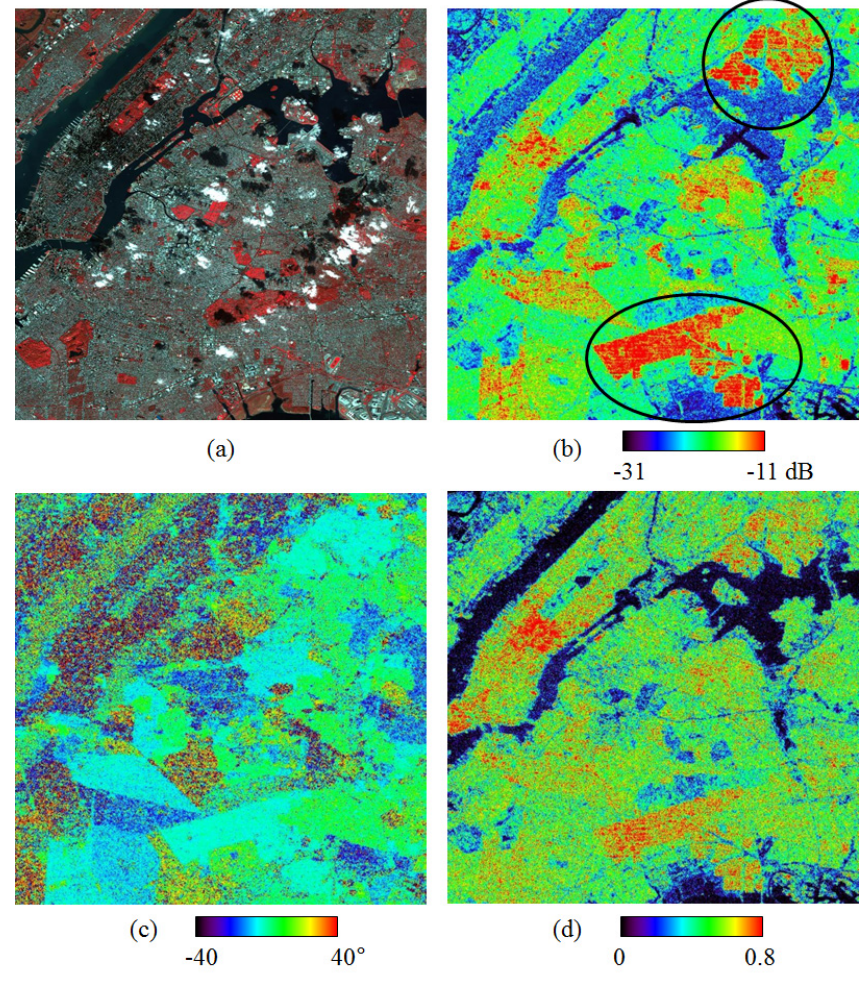
Figure 1. Urban density of New York estimated from a fully polarimetric PALSAR image. (a) AVNIR-2 image, (b) TP , (c) POA and (d) T v + c . In the circle and ellipse of (b), where low-storied buildings are available, strong backscattering is observed because the POAs are almost 0 ◦ . In (d), T v + c was calculated in the urban areas estimated by applying the method reported by Kajimoto and Susaki (2013a). Each panel has a slant range coordinate system.